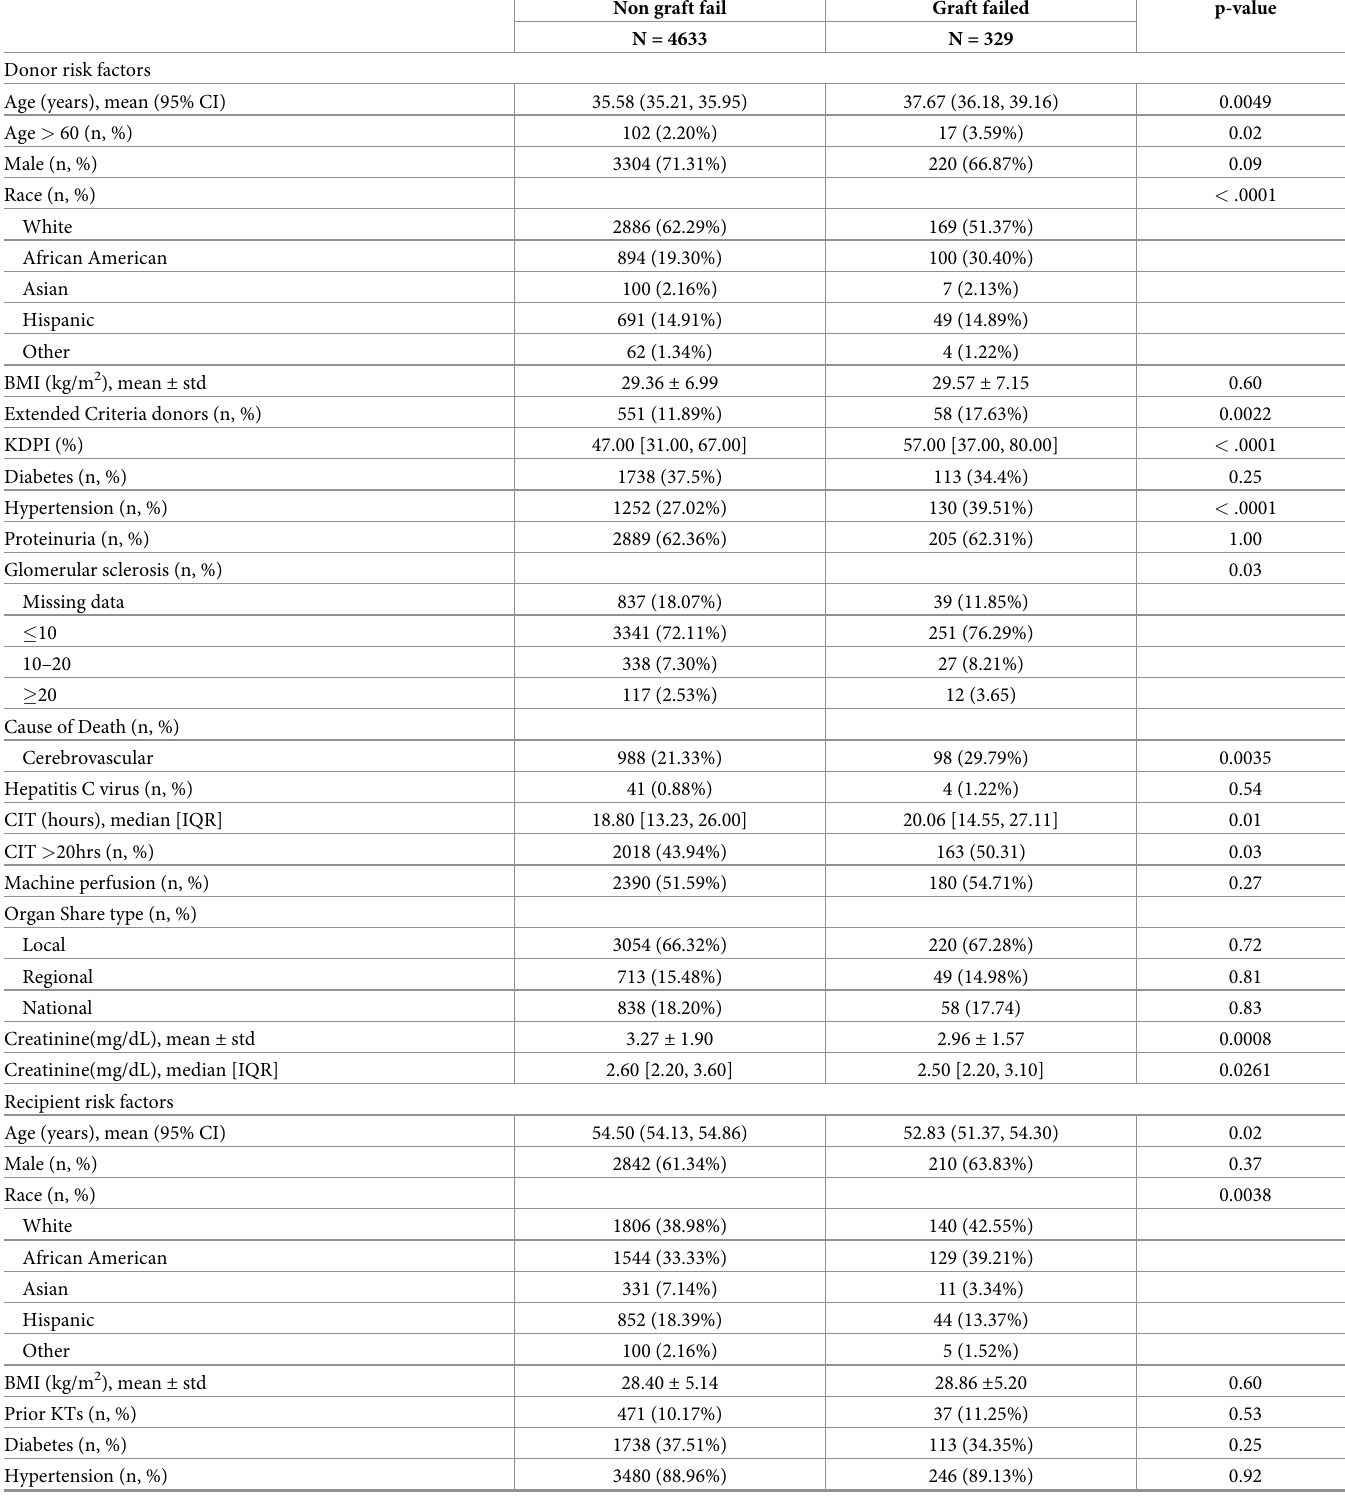
Table 3. Donor, recipient and transplant risk factors predicting graft failure in AKI donor